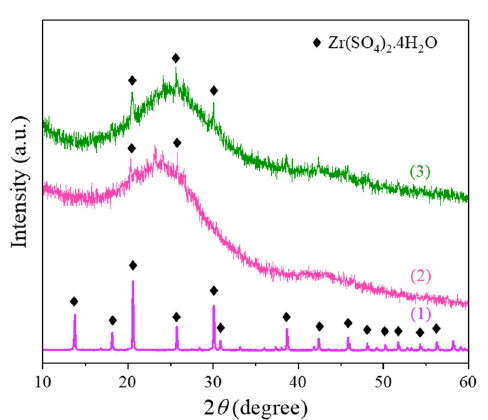
Figure 1. XRD patterns of ( 1 ) Zr(SO 4 ) 2 · 4H 2 O, ( 2 ) Zr(SO 4 ) 2 / SiO 2 , and ( 3 ) Zr(SO 4 ) 2 / activated carbon (AC). Zr(SO 4 ) 2 loading and textural properties of SiO 2 , Zr(SO 4 ) 2 / SiO 2 , AC, and Zr(SO 4 ) 2 / AC samples